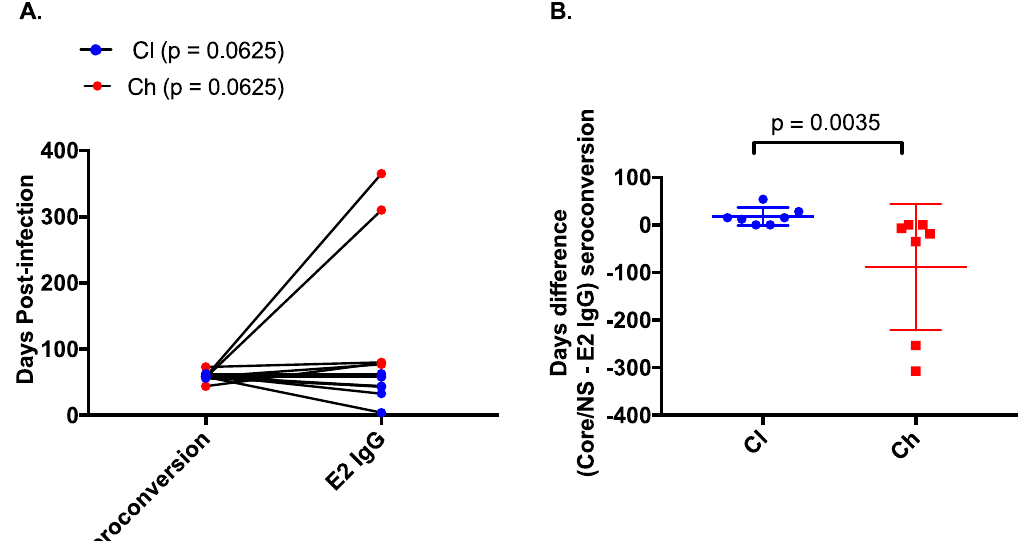
Figure 3. Comparison of E2-specific IgG binding and non-E2 specific binding in clearer and chronic progressor subjects. The timing (days post infection) of anti-E2 specific IgG as measured by ELISA was compared to the timing of core / non-structural protein (NS) seroconversion as measured by the commercial Abbott assay ( A ) for clearers (blue) and chronic progressors (red). The di ff erence in days between the appearance of anti-E2 IgG and anti-core / NS was compared between clearers (blue) and chronic progressors (red) ( B ).